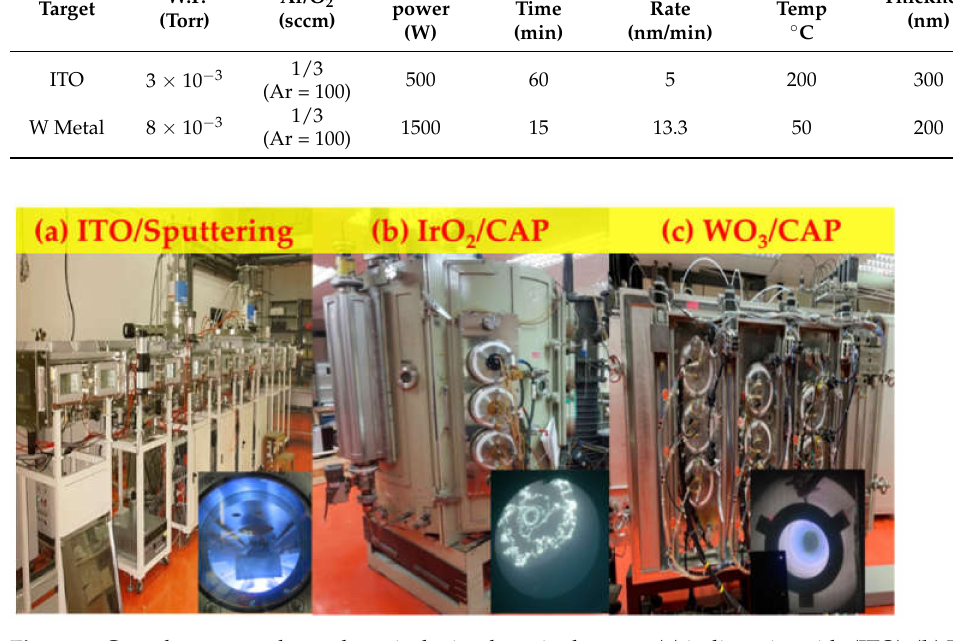
Figure 1. Complementary electrochromic device deposited system ( a ) indium tin oxide (ITO), ( b ) IrO 2 electrode, and ( c ) WO 3